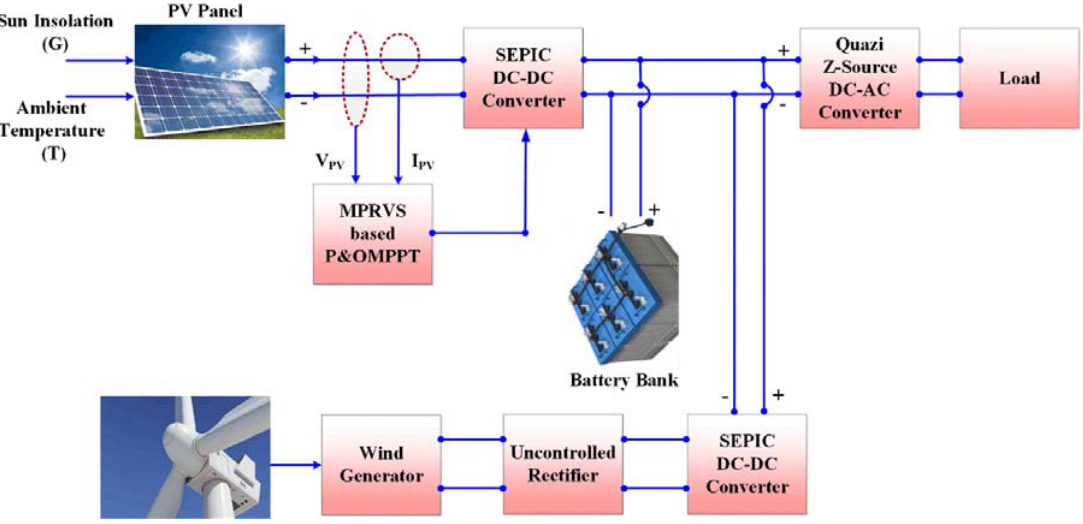
Figure 1. A block diagram with the structure of Hybrid PV ‐ Wind micro grid system.